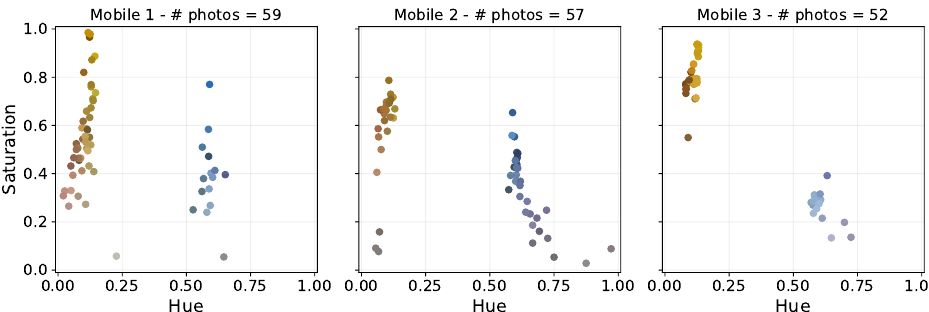
Figure 3. Scatter plots of the colour extracted from the photos taken by the three devices with more uploads to the NightUp application.